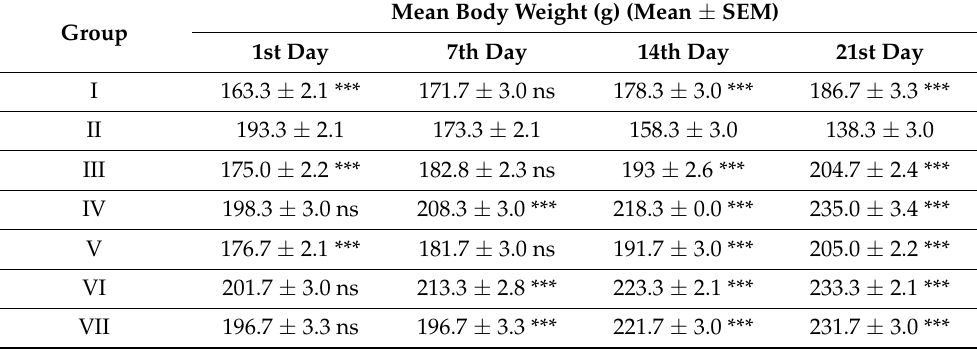
Table 4. Graphical representation of TPE and TPE-ZnO NPs’ effects on body weight (g) in STZ- induced diabetic rats.